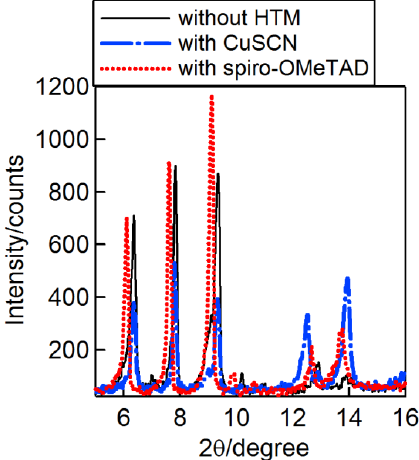
Figure 5. XRD patterns of the one-step-processed CH 3 NH 3 PbI 3 perovskite layers with 5-aminovaleric acid (5-AVA) doping, varied by hole-conducting materials (HTM) on the perovskite layer. represented as